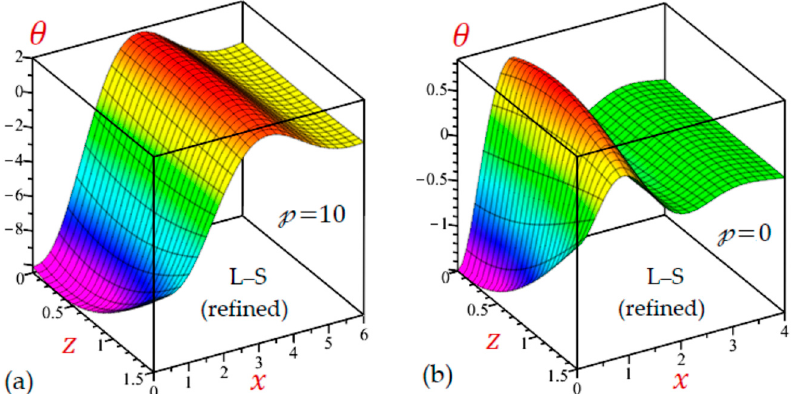
without initial pressure ( 𝓅 = 0 ) ( a ) 𝜎 (cid:2868) = 9 ; ( b ) 𝜎 (cid:2868) = 5 .